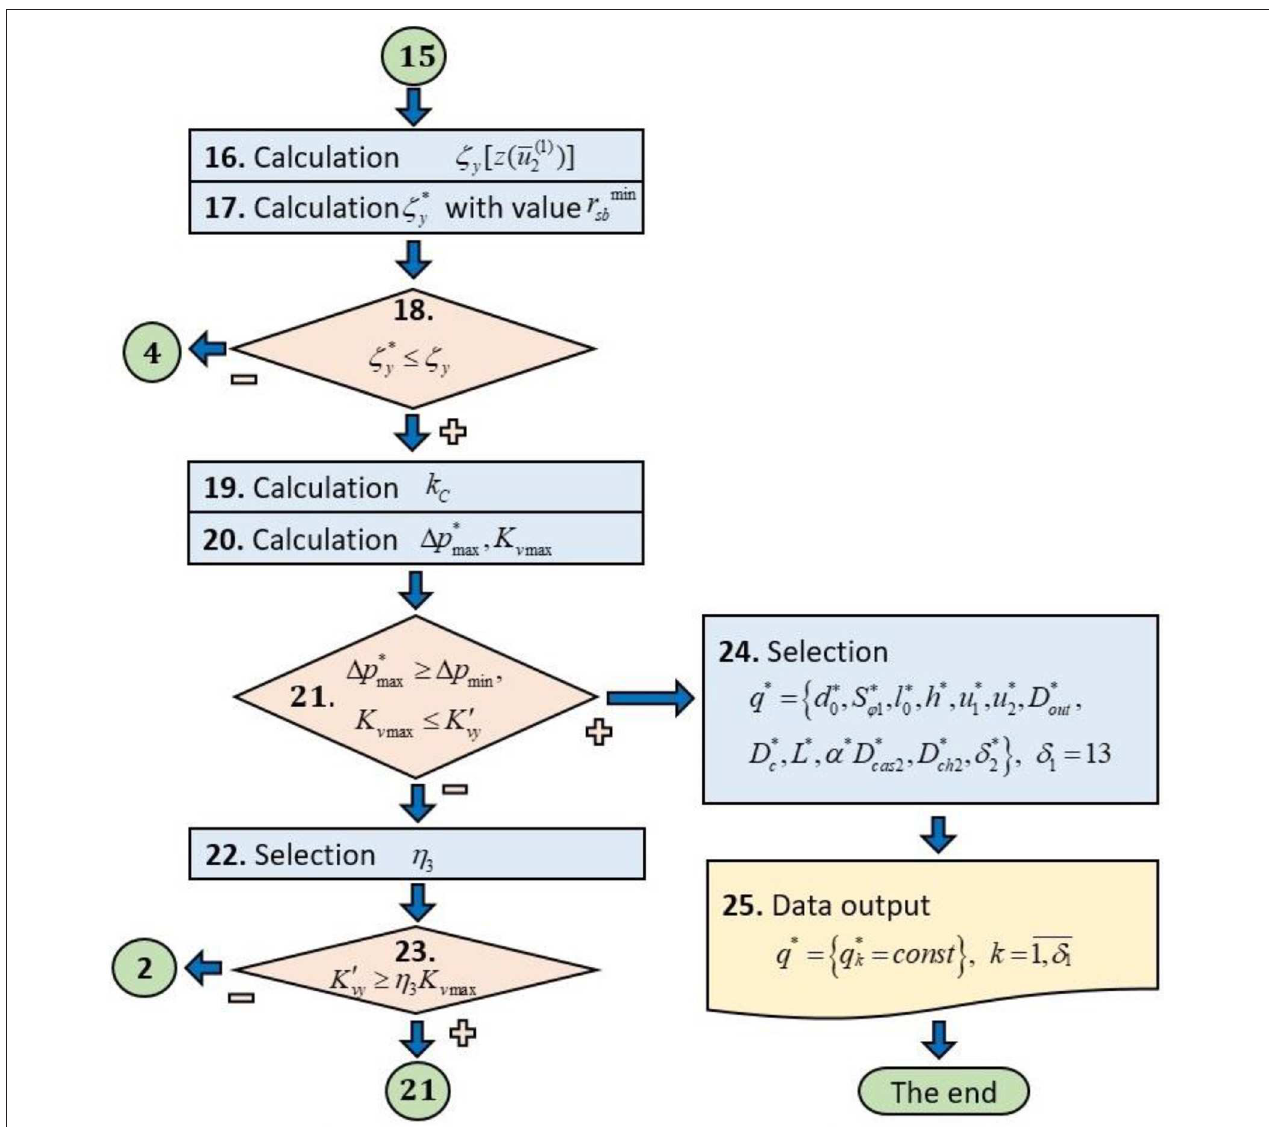
FIGURE 3 | Conventional block diagram of the calculation of the design parameters of the axial valve separator with the external location of the locking member (Part 2).